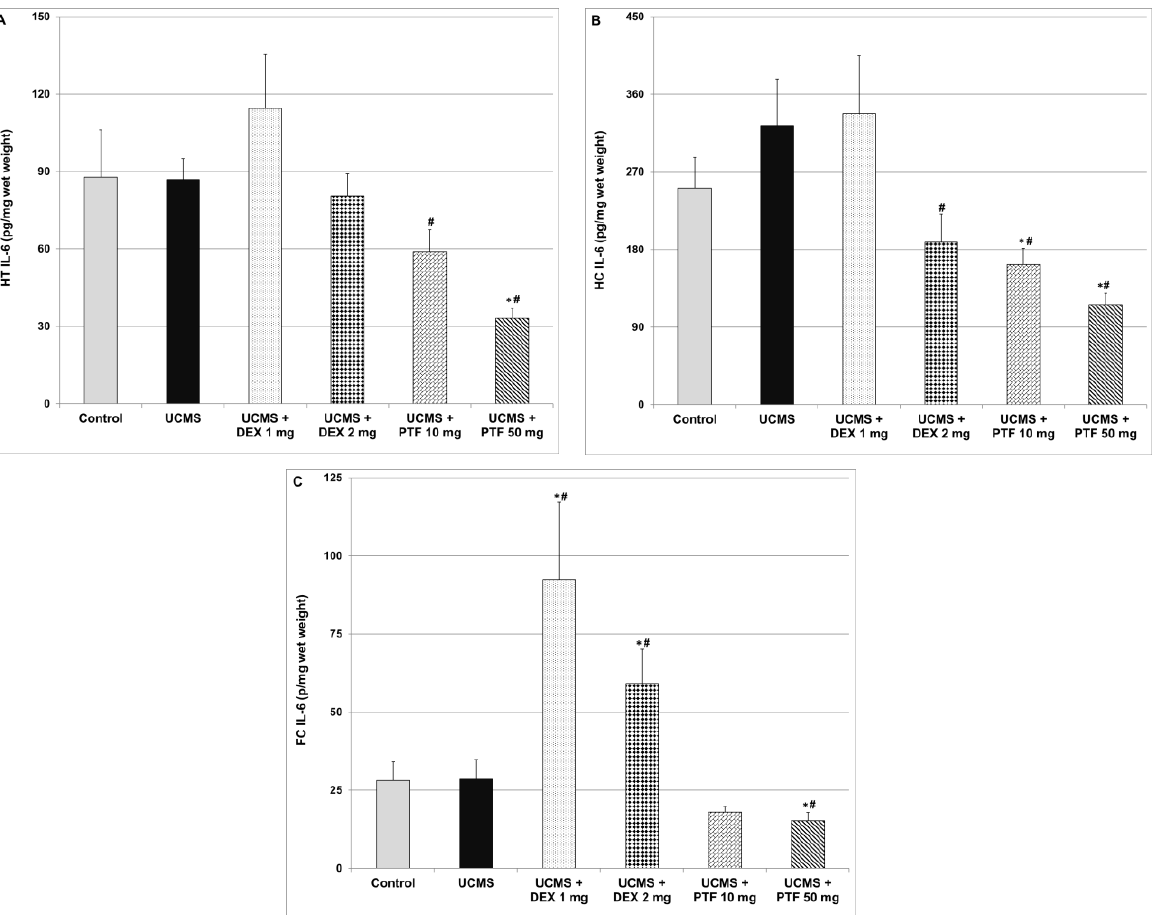
Figure 5. Effects of DEX and PTF on IL-6 levels in brains of UCMS rats. ( A ) Hypothalamus (HT), ( B ) hippocampus (HC) and ( C ) frontal cortex (FC). Values are means ± SEM of 11–12 rats in each group. ( A ) One-way ANOVA test: F = 5.11, p = 0.0014; t -test: * p < 0.05 vs. control, # p < 0.05